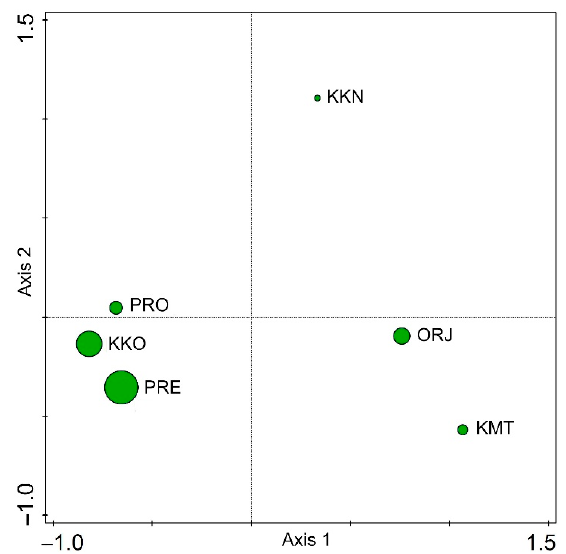
Figure 5. Ordination diagram based on nonmetric multidimensional scaling (NMDS) of fungal communities associated with needles of Pinus heldreichii from six different sites in Montenegro, with 56.5% variation on Axis 1 and 28.2% on Axis 2. Each point in the diagram represents a single site and the size of the point reflects richness of the fungal taxa as in Table 2. Sites are as in Table 1. At ORJ and KMT sites that are characterized by harsh growing conditions, the fungal community was dominated by Lophodermium pinastri , Sydowia polyspora , Phaeomoniella sp., Allanthopomopsiella pseudotsugae , Lachnellula calyciformis , Ramoconidiophora euphorbiae , Collophorina sp., Geastrumia sp. and Mollisia ligni (Table 3). At PRE, PRO and KKO sites that are characterized by moderate growing conditions, fungal community was dominated by Lophodermium conigenum , L. pinastri , Cyclaneusma niveum , Phaeosphaeria punctiformis , Unidentified sp. 2814_11, Cenangium acuum